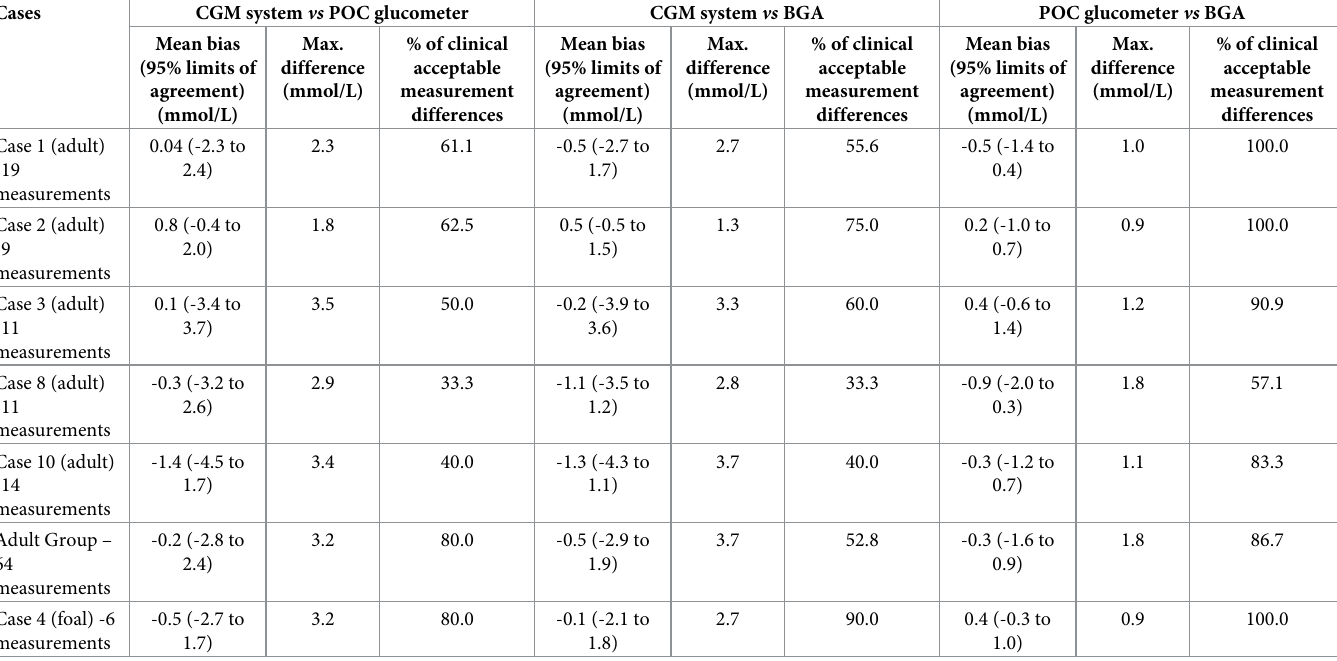
Table 2. Bland Altman analyses and comparative statistics of the three glucose measurements